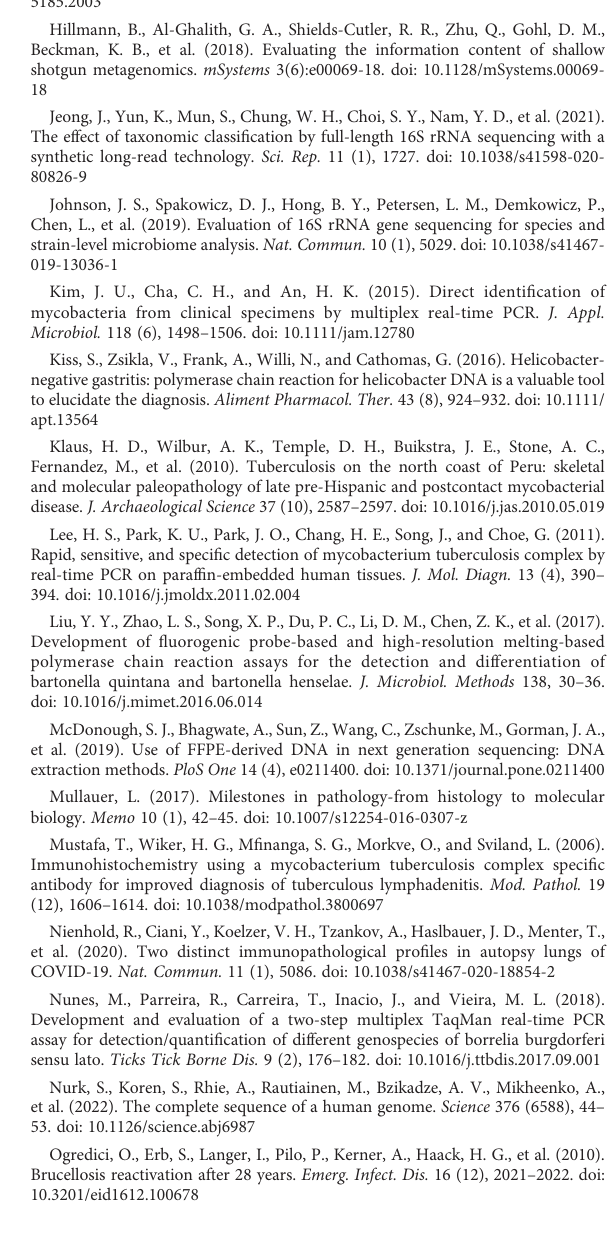
detection of S. aureus by metagenomics analysis. SUPPLEMENTARY FIGURE 4 Sunburst graph depicting phylogeny and quantity of bacteria detected in the most complex case of infection in a human FFPE lung. Each circle represents a phylogenic level, starting with the kingdom level in the inner ring and ending with the species level at the outer